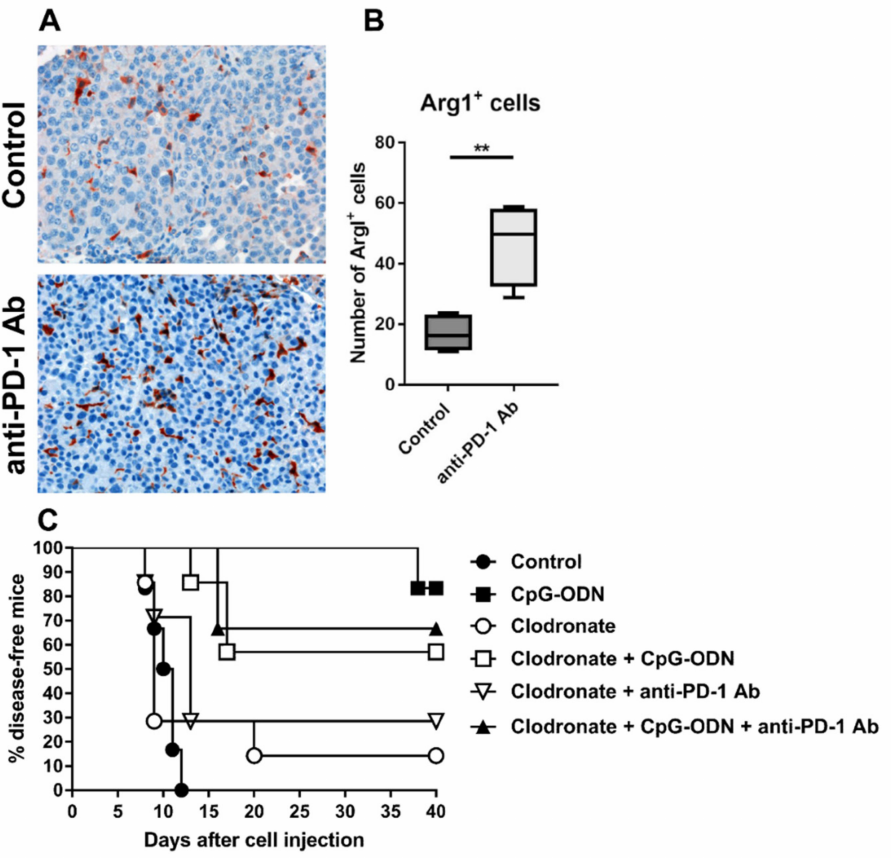
Figure 3. Role of macrophages in the dampening of the antitumor activity of CpG-ODNs. ( A , B ) An anti-mouse PD-1 antibody induced the accumulation of arginase I+ (ArgI + ) myeloid elements in the tumor microenvironment. Eight-week-old female athymic nude mice were i.p. injected with IGROV-1 cells and treated i.p. with a monoclonal anti-mouse PD-1 antibody at a dose of 200 µ g/mouse 5 times at two- or three-day intervals. Treatment started the day after tumor cell injection. Control mice received saline. ( A ) Representative histopathological evaluation and ( B ) quantification of ArgI- stained IGROV-1 tumor samples from mice treated with the anti-PD-1 antibody or untreated mice. Original magnification: 20 X. ( C ) Kaplan–Meier plot of percent disease-free IGROV-1 ovarian tumor- bearing mice treated with CpG-ODNs, an anti-PD-1 antibody or their combination after macrophage depletion. Mice xenografted with IGROV-1 human ovarian cancer cells were treated i.p. with liposomes containing clodronate three days after tumor cell injection. The animals were then i.p. injected with CpG-ODN (20 µ g/mouse, 5 days/week for 3 weeks, starting seven days after tumor cell injection), i.p. injected with an anti-PD-1 antibody (clone RMP1-24) (200 µ g/mouse, 2 times/week for 3 weeks, starting seven days after tumor cell injection) or administered the combination of these treatments. The control group received saline. ** p < 0.01 by unpaired t -test. CpG-ODNs: CpG oligodeoxynucleotides; anti-PD-1 Ab: anti-PD-1 antibody. On the same line, immunofluorescence quantitative analysis showed increased infil- tration of elements positive for CD206, a mannose receptor expressed by macrophages with M2 phenotype that are associated with tumor progression in ovarian cancer [41], in the tumor stroma of anti-PD-1-treated mice compared to the untreated group (Figure S2A,B). The augmented infiltration of macrophages in anti-PD-1 treated animals was also paral- leled by a higher presence of cells positive for IL-10, an immunoregulatory cytokine that can be also expressed by M2 macrophages [42], compared to control mice (Figure S2C,D). These observations suggest that macrophages may be involved in restraining the antitumor efficacy of